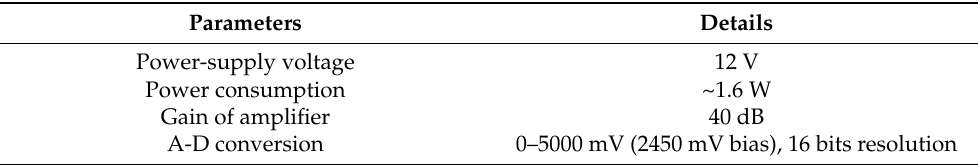
Table 1. Assumed parameters of the developed EFM system.